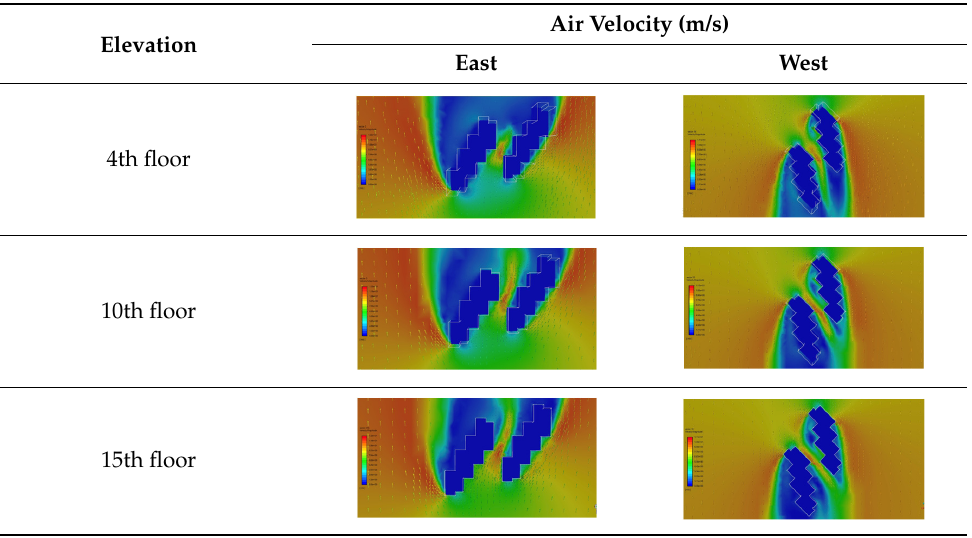
Table 4. Field measurement data used in the simulation.